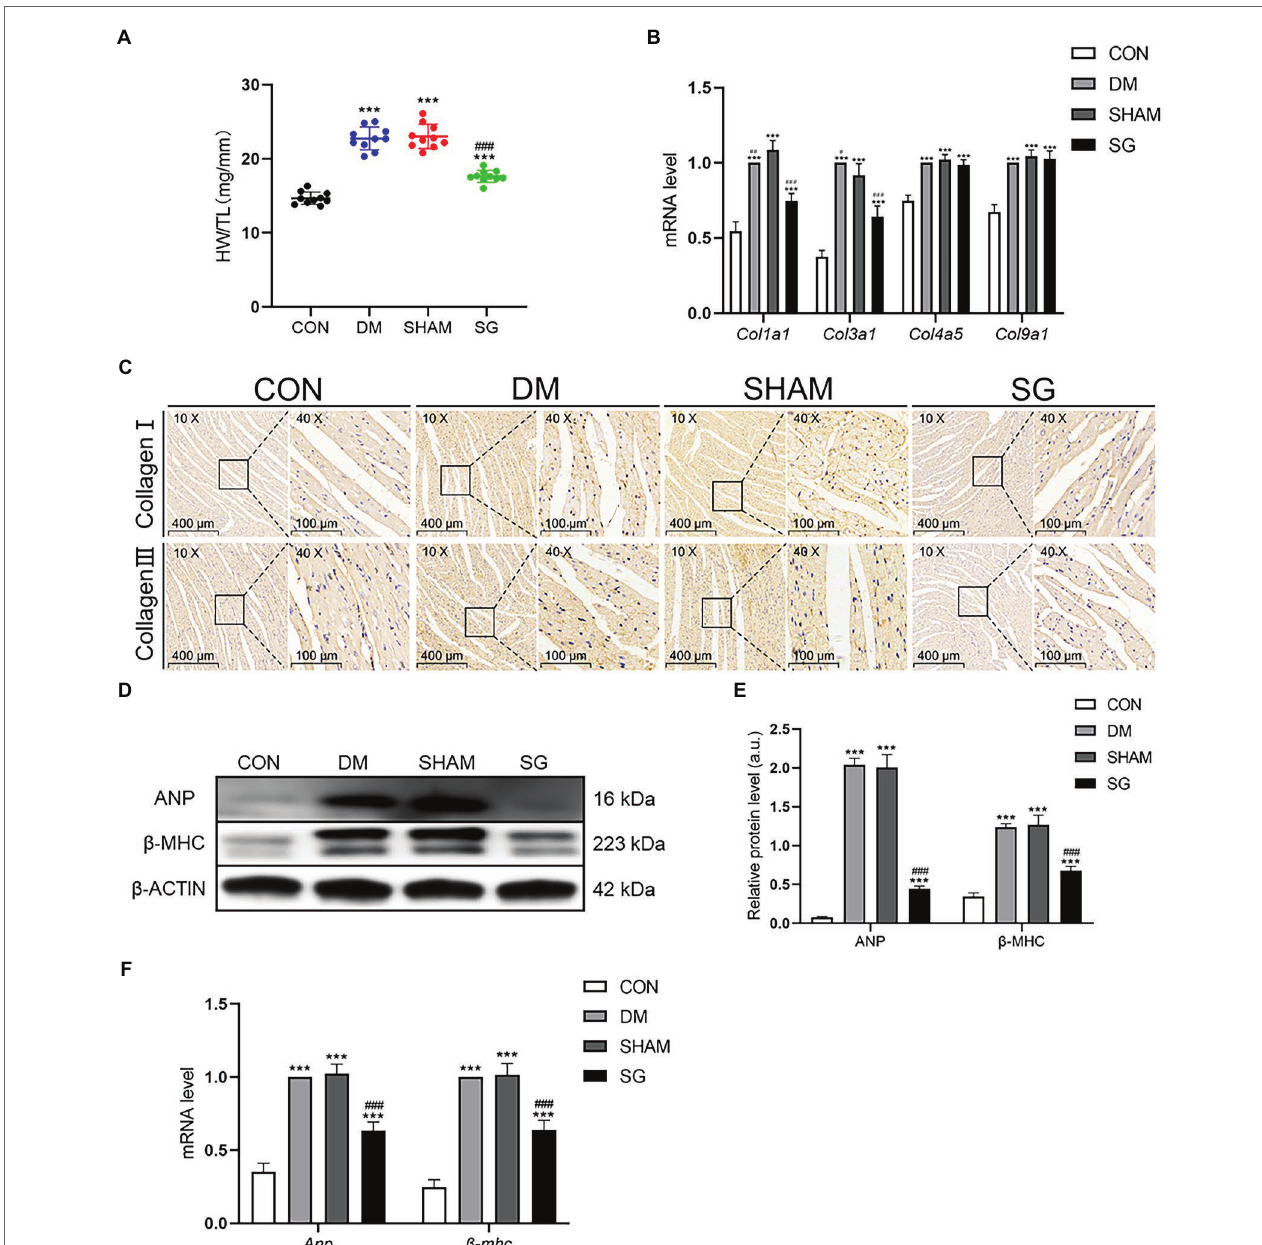
FIGURE 3 | The positive effect of SG on the heart basic parameters and the expression of collagen. (A) HW/TL was measured. (B) Heart mRNA levels of Col1a1 , Col3a1 , Col4a5 , and Col9a1 were measured. (C) The representative immunohistochemical staining of collagen I and collagen III (magnification 10×, scale bars represent 400 μ m; magnification 40×, scale bars represent 100 μ m). Brown staining is considered positive. (D) The representative bands of ANP and β -MHC and (E) relative protein level of ANP and β -MHC were quantitatively analyzed. (F) Heart mRNA levels of Anp and β -mhc were measured. Data are expressed as means ± SEM for n = 10 per groups. * p < 0.05 vs. CON group, ** p < 0.001 vs. CON group, *** p < 0.0001 vs. CON group; # p < 0.05 vs. SHAM group, ## p < 0.001 vs. SHAM group, ### p < 0.0001 vs. SHAM group. HW/TL, heart weight/tibial length; CON, control; DM, diabetes mellitus; SHAM, sham operation; SG, sleeve